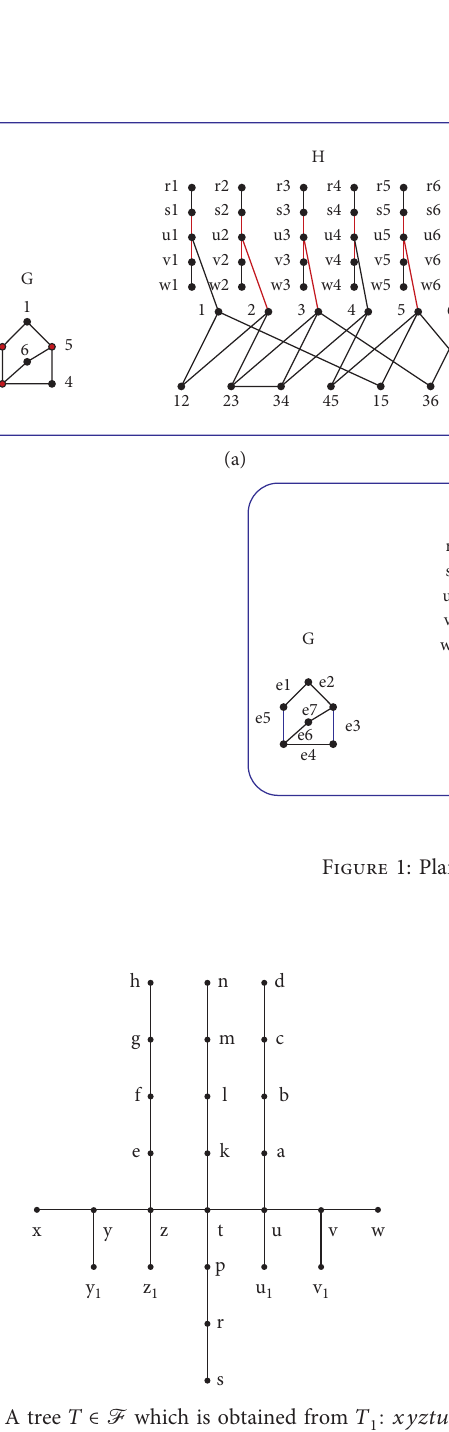
, z , u , v with Process O 1 1 1 1